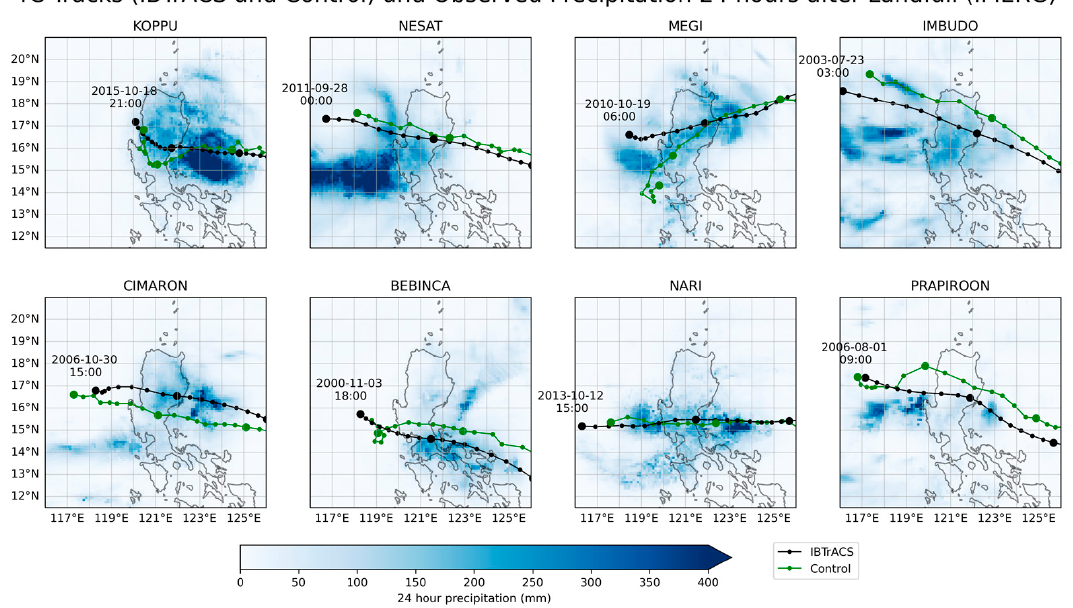
Figure 3. Three-hourly observed (black) and simulated (green) TC track points for Control for all eight cases. These are plotted for up to 24 h after observed TC landfall based on IBTrACS. Larger markers denote 24 h periods, matched between observations and simulations, while the final point in the model track corresponds to the same time and date as the labelled observed point. The blue shading denotes the 24 h accumulated precipitation (in mm) from IMERG. Observed track data are from IBTrACS [19], while precipitation data are from IMERG [21].